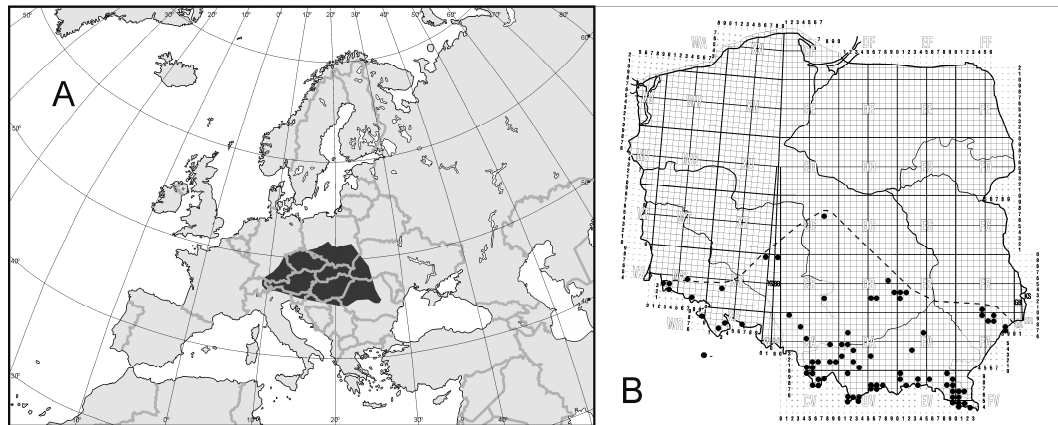
Figure 1. Range of Trachytes irenae : ( A ) in Europe, ( B ) in Poland; black dots—recorded occurrences of the species, dotted line—northern range boundary.